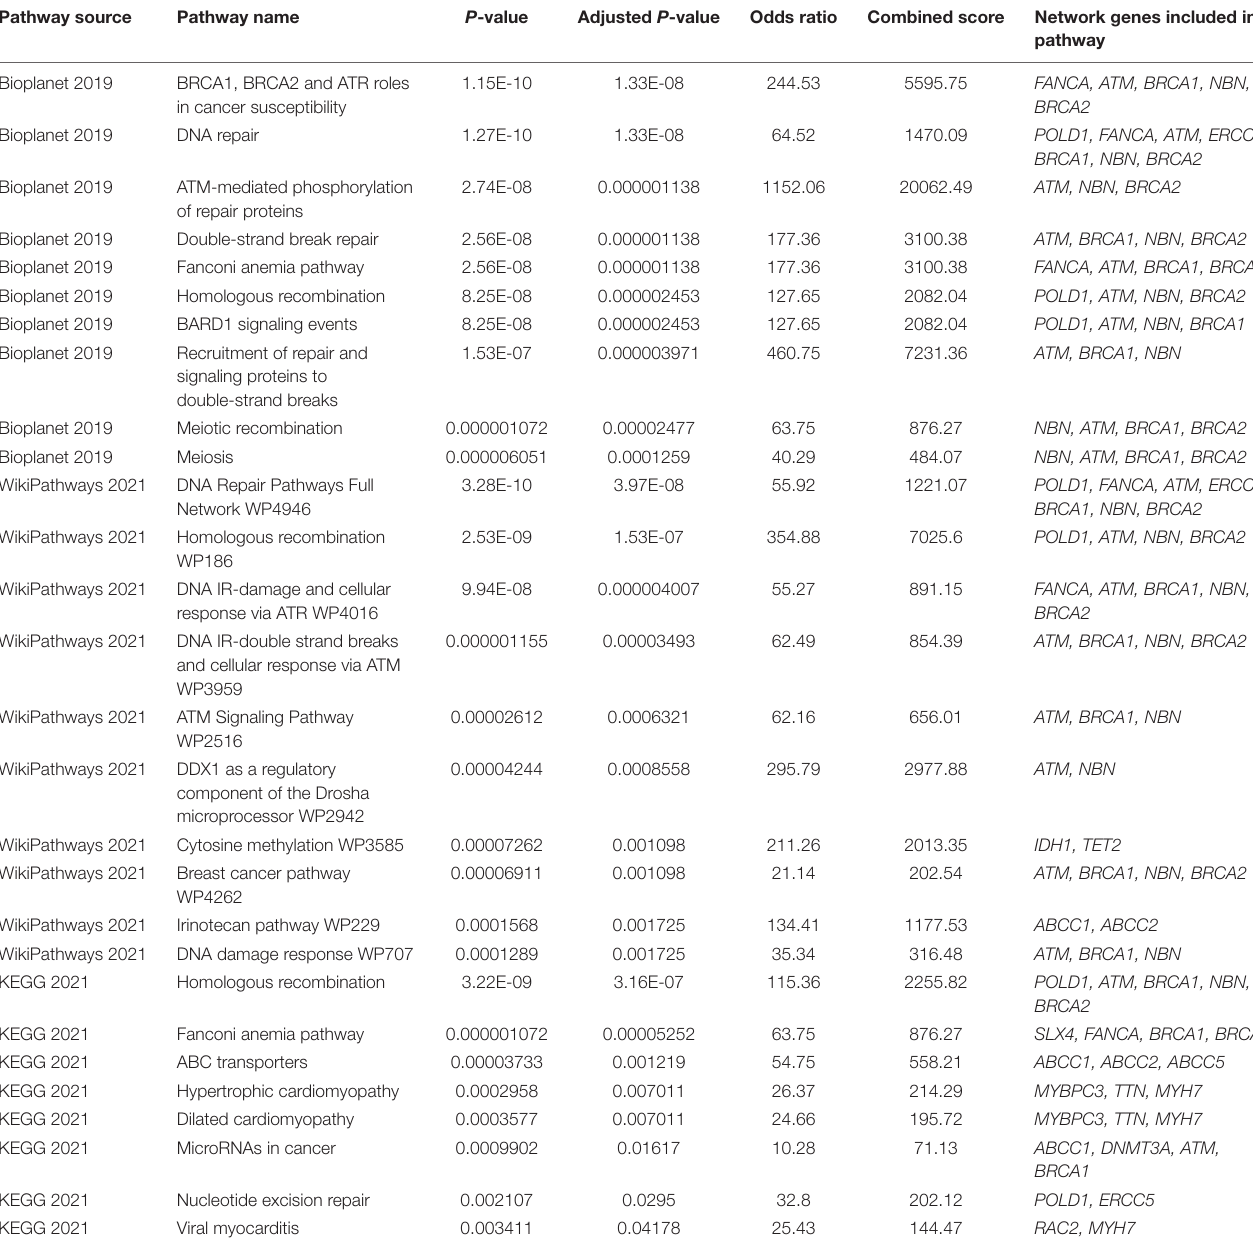
TABLE 1 | Pathway enrichment analysis for 28 genes associated with cancer and